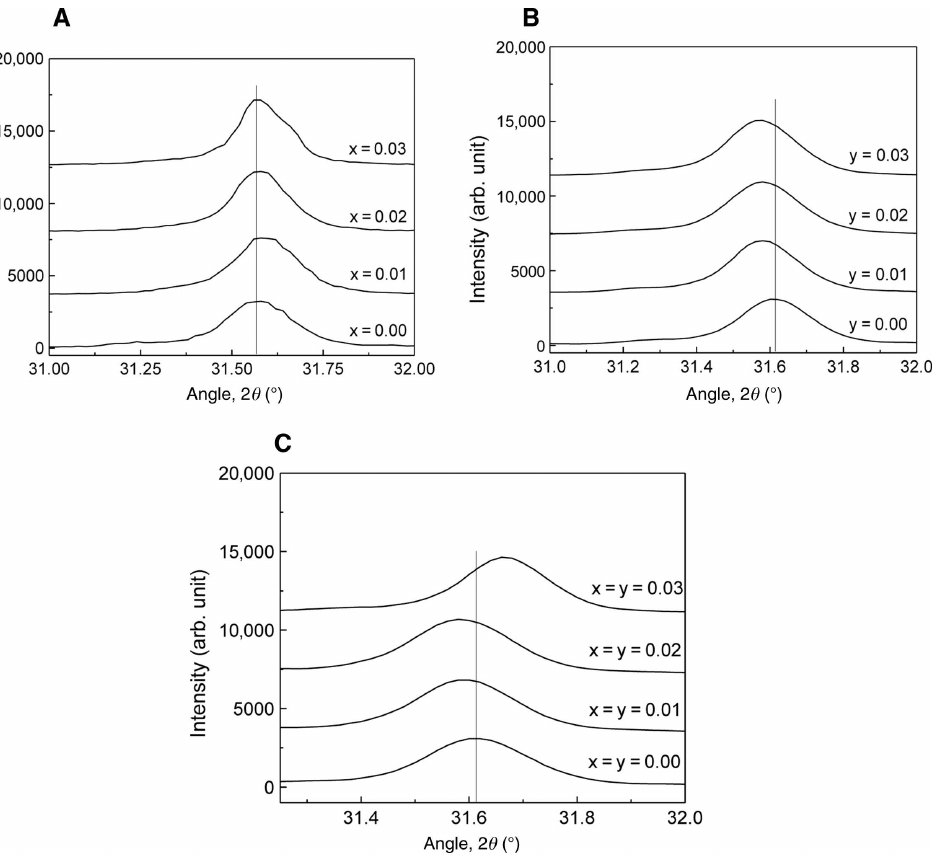
Figure 3: XRD profile around (110) peaks of the (A) Ba 1 − x Ce x TiO 3 (where x = 0.00, 0.01, 0.02, 0.03), (B) BaMn y Ti 1 − y O 3 (where y = 0.00, 0.01, 0.02, 0.03), and (C) Ba 1 − x Ce x Mn y Ti 1 − y O 3 (where x = y = 0.00, 0.01, 0.02, 0.03)